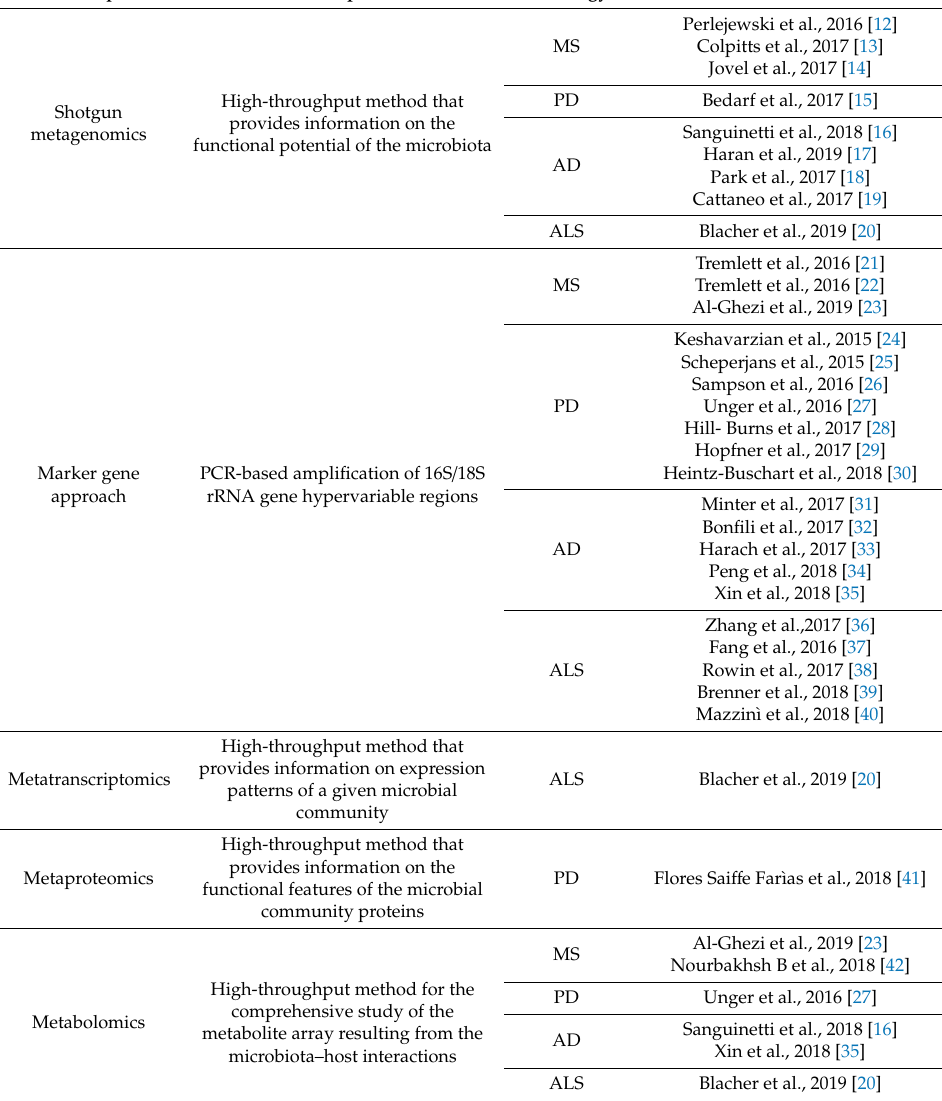
Table 1. Summary of relevant meta-omics studies correlating the gut microbiota to multiple sclerosis (MS), Parkinson’s disease (PD), Alzheimer’s disease (AD), and amyotrophic lateral sclerosis (ALS). The most recent studies are sorted depending on the method employed for the microbiota